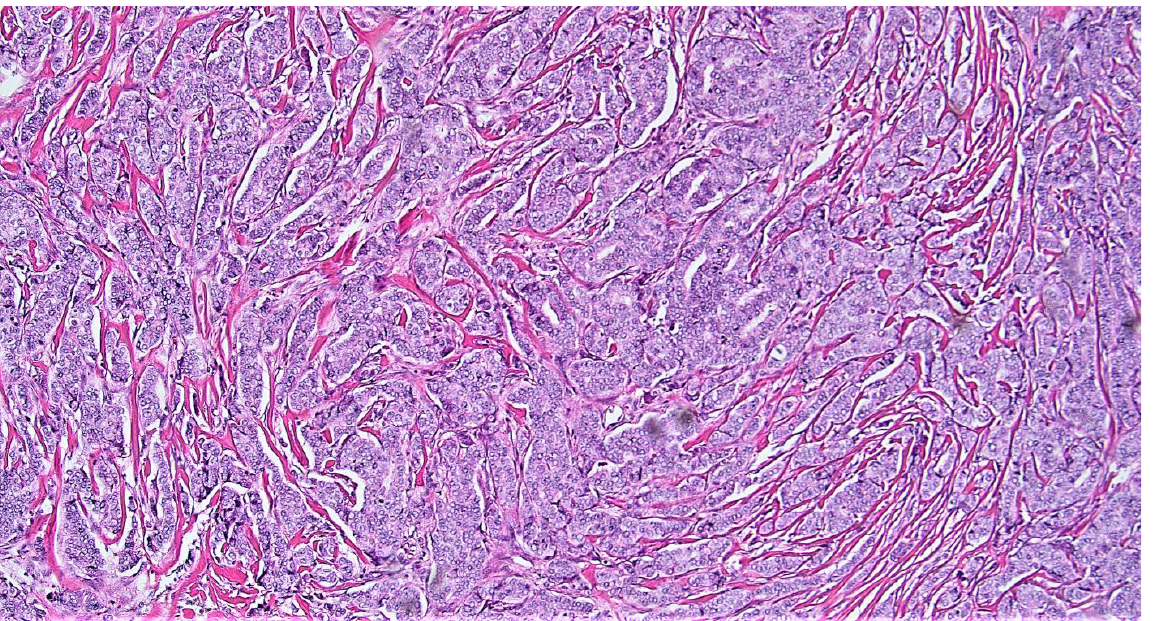
Figure 5. (10×): A very low-risk ODX patient considered to be high-risk by the aMMs with a breast cancer recurrence (Supplemental Table S2—case # 1). Note the intermediate grade histologic qualities. This patient was 69 years of age with an aMMs of 19.2, a Ki-67 of 30%, and an ODX recurrence score of 6.